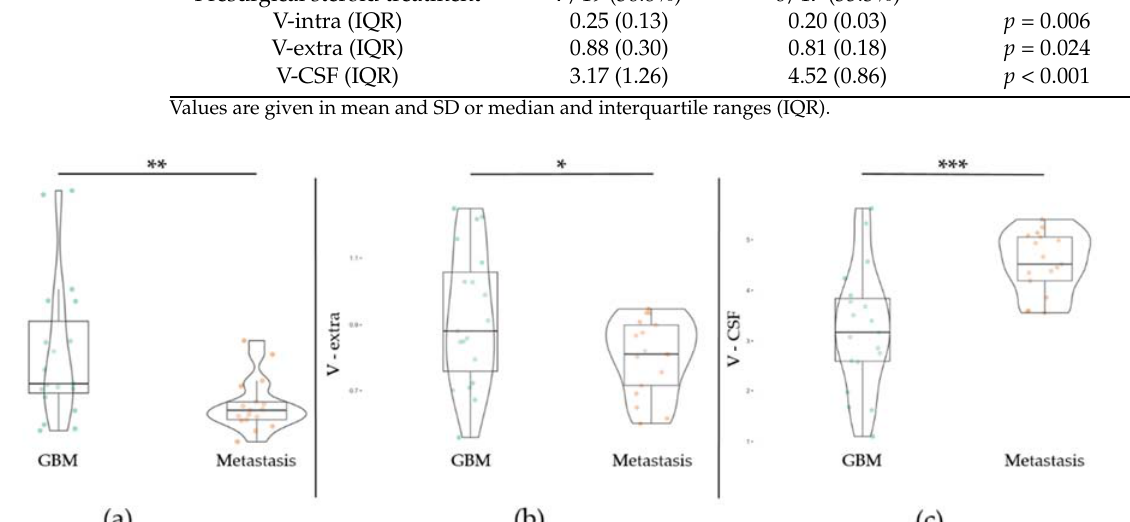
Figure 4. Normalized perilesional (T2) diffusion microstructure imaging (DMI) metrics in patients with GBM ( n = 19) and metastases ( n = 17), normalized to whole-brain normal-appearing white matter (NAWM) values. Compared to GBM, metastases show a significant shift towards increased interstitial free water (( c ); V-CSF) and decreased V-intra and V-extra ( a , b ). * p ≤ 0.05; ** p ≤ 0.01; *** p ≤